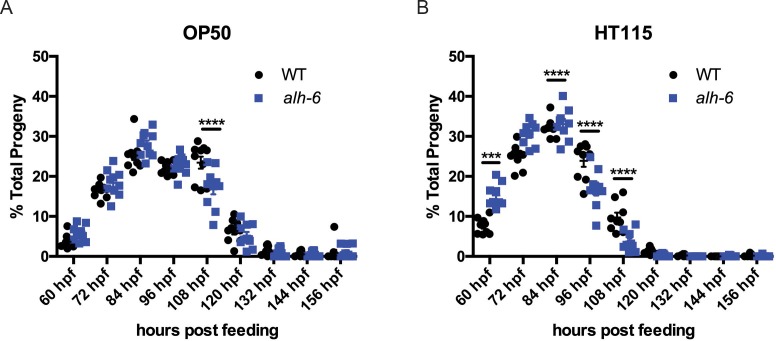
alh-6 hermaphrodite reproductive span is similar to wild type (WT) on different diets.(A–B) Progeny output time-courses are plotted as % total progeny for each time point. WT and alh-6 mutant have similar output on OP50 (A) and HT115 (B). Significance indicate differences in progeny output at a particular time point done by multiple t-tests. *, p<0.05; *F*, p<0.01; ***, p<0.001; ****, p<0.0001. All studies performed in biological triplicate; refer to Supplementary file 1 for n for each comparison.